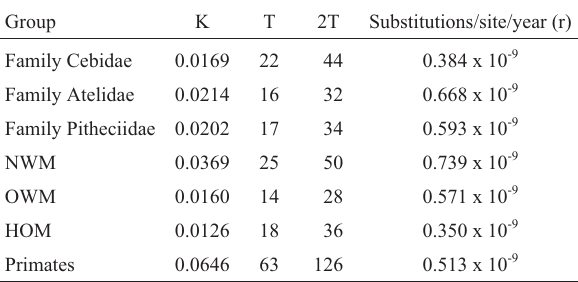
Table 3 - Estimates of the evolution rates (r) of the H gene in the different groups of primates analyzed in the present study. Primate groups as in Table 2. Divergence times (T) are given in millions of years, according to Goodman et al . (1998). Group K T